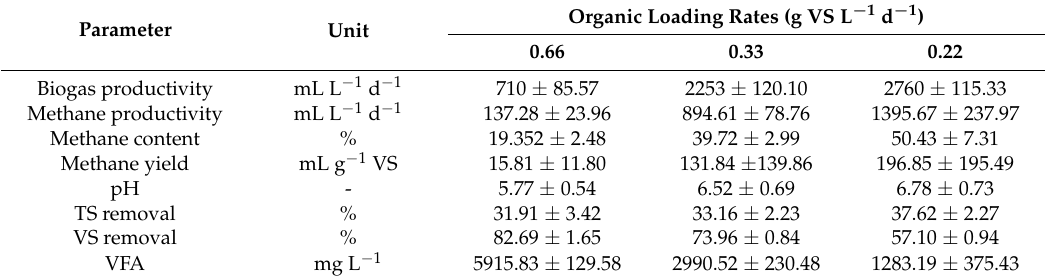
Table 3. Summary of performance parameters for semi-continuous anaerobic